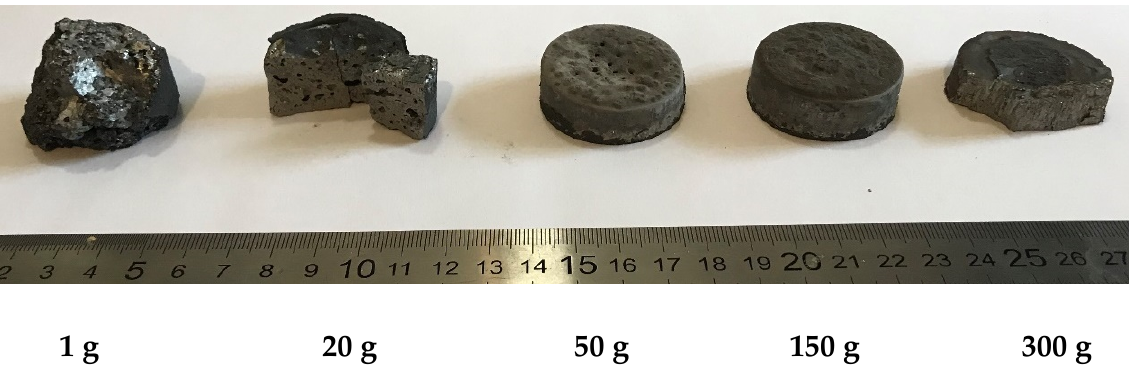
Figure 1. The appearance of NiAlCr(Co)-2.5%Mo alloy ingots produced at different acceleration values (g). A comparative data analysis revealed no significant differences in the degree of phase separation of the synthesis products and dispersion of the mixture during synthesis of the samples with basic composition [24] and the compositions analyzed in this study. However, slight variation in combustion velocity ( U f ) of the mixtures was detected. Figure 2 shows the combustion velocity U f of the analyzed mixture compositions as a function of acceleration. The reported data are the average of three experimental values.